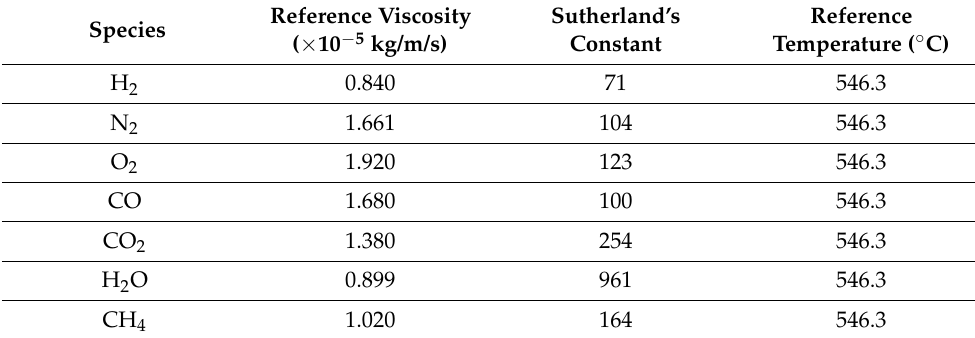
Table A3. Parameters of viscosity, according to species [19].